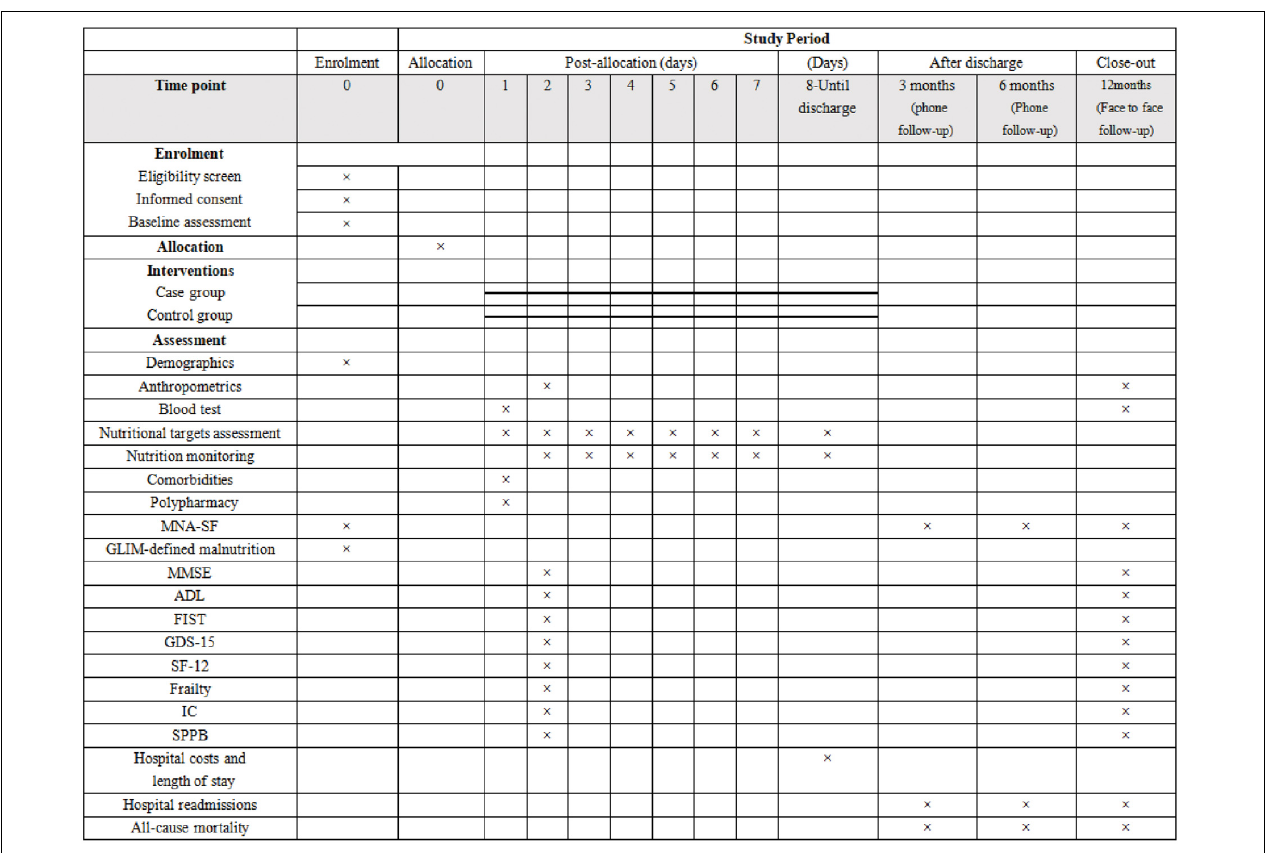
FIGURE 4 | Diagram for time schedule of enrolment, allocation, and assessment. MNA-SF, Mini Nutritional Assessment Short Form; GLIM, the Global Leadership Initiative on Malnutrition; MMSE, Mini-Mental State Examination; ADL, Activities of Daily Living scale; FIST, functional impairment screening tool; GDS-15, the 15-item geriatric depression scale; SF-12, the 12-item short form health survey; IC, intrinsic capacity; SPPB, short physical performance